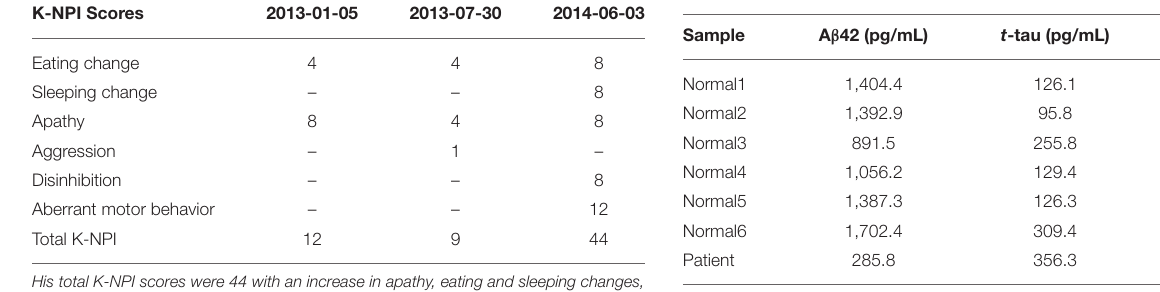
TABLE 2 | Cerebrospinal fluid (CSF) analysis on the patient compared to 6 cognitive normal samples revealed downregulated A β 42; Total-tau and Phosphorylated-tau showed decreased values, suggesting tauopathy did not start.